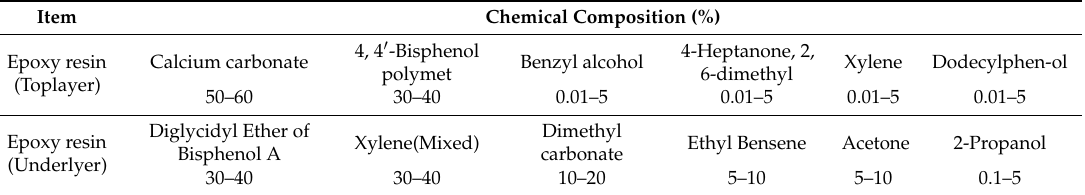
Table 4. Chemical composition of epoxy surface finisher.